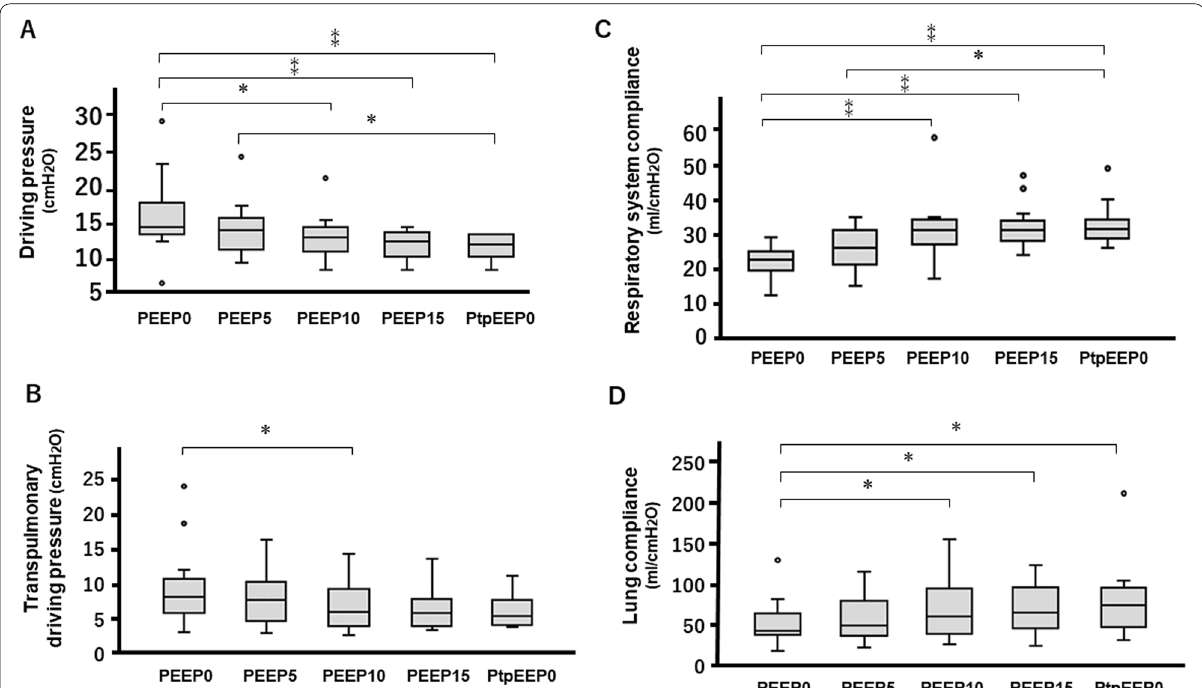
Fig. 1 Effects of increasing PEEP on driving pressure ( A ), transpulmonary driving pressure ( B ), respiratory system compliance ( C ), and lung compliance ( D ) during robot assisted laparoscopic prostatectomy. PtpEEP0 PEEP levels corresponding to the end-expiratory transpulmonary